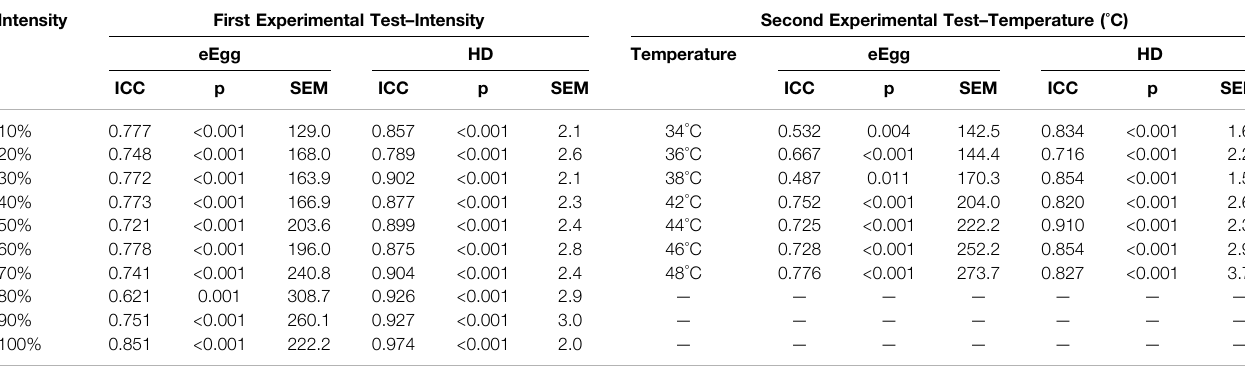
TABLE 2 | Test-retest-reliability — ICC and SEM values: average measurements, intensity and thermal stimuli. Intensity First Experimental Test – Intensity Second Experimental Test – Temperature ( ° C)